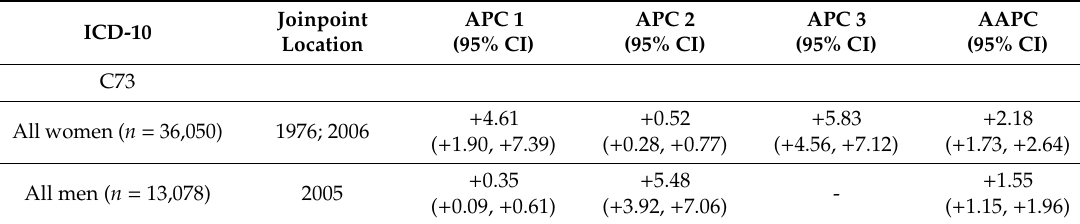
Table 3. Joinpoint regression analysis of thyroid cancer incidence in women and men in the Nordic countries according to NORDCAN 1970–2016, ICD-10 code C73 (https: // www-dep.iarc.fr / NORDCAN / english / frame.asp). APC = Annual Percentage Change (APC 1 = time from 1970 to first joinpoint; APC 2 = time from first joinpoint to 2016 or to second joinpoint; APC 3 = time from second joinpoint to 2016); AAPC = Average Annual Percentage